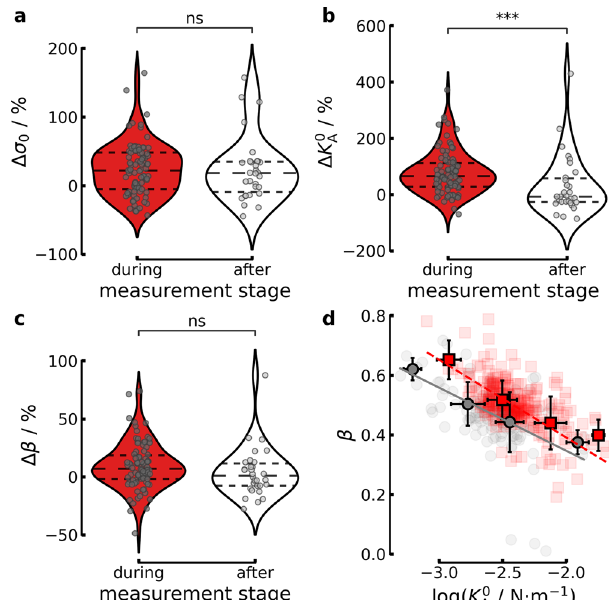
the maximum indentation depths δ max see Supplementary Fig. 8. and fl uidity a – c Change of prestress Δ σ 0 , area compressibility modulus Δ K 0 A Δ β normalized to the values obtained prior to strain (in %). Red denotes the cells during strain and white corresponds to the cells after strain was released, respectively. The gray points are the changes of single cells averaged over multiple indentations and the dashed lines mark the quartiles. d Scaling of β ð log ð K 0 ÞÞ . Gray circles correspond to unstrained A cells and red squares to the same cells after strain is applied, respectively ( n = 90 cells during, n = 30 cells after). The dark gray circles (prior) and dark red squares (during) are the binned averages, with the error bars showing the standard deviation. The solid gray line and dashed red line is a linear fi t of the averaged data, prior or during strain application,